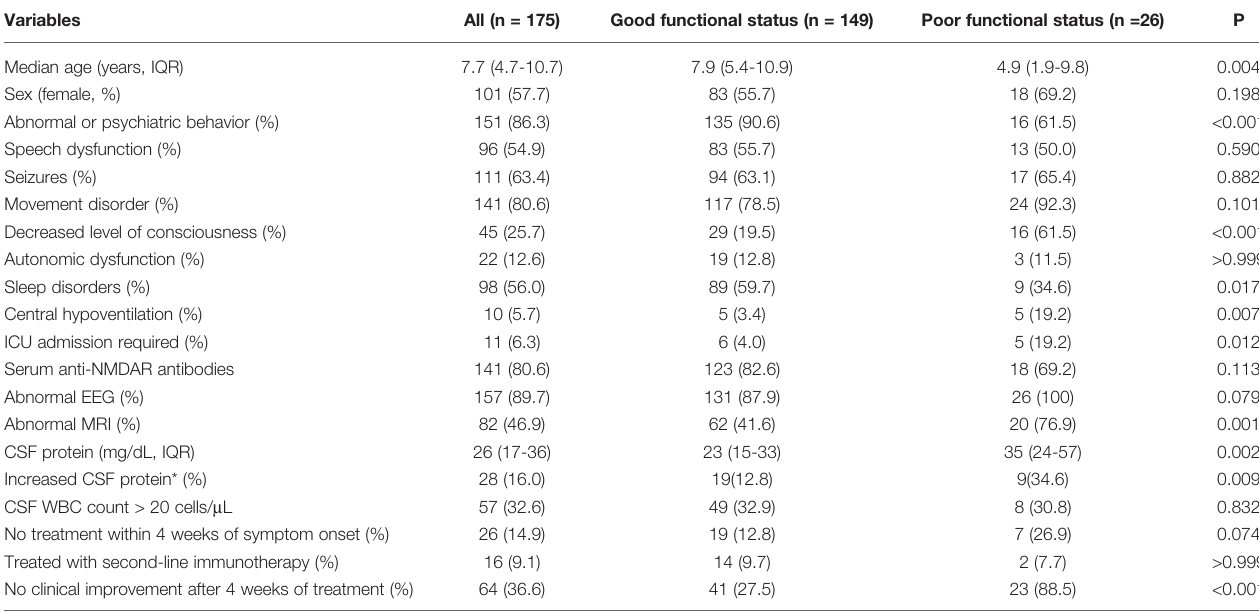
TABLE 2 | Clinical characteristics of children with anti-NMDAR encephalitis.